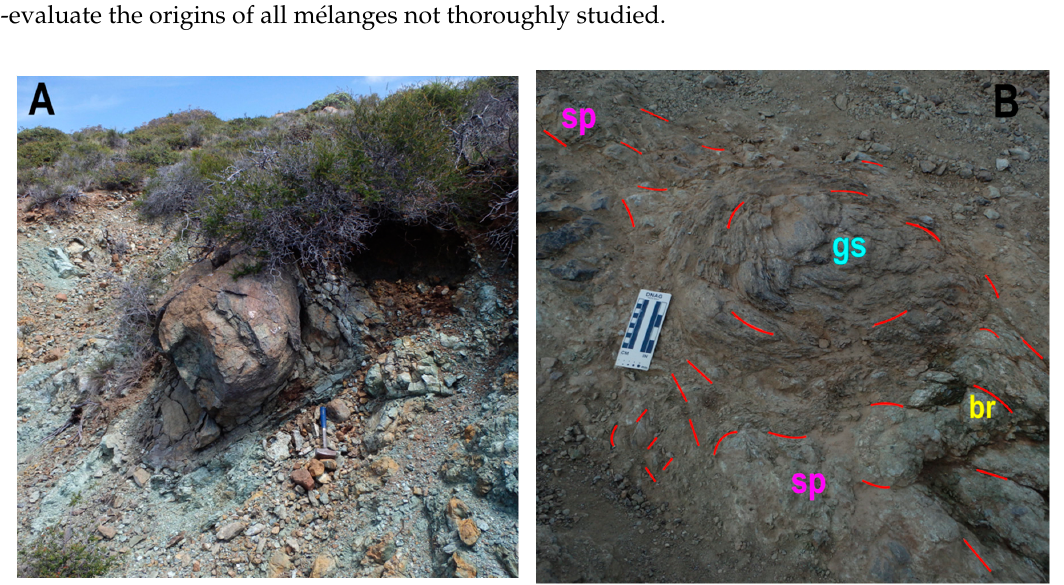
Figure 8. Rounding of serpentinite clasts in mélanges and serpentinite broken formations. ( A ) A combination of jointing, weathering with exfoliation, and shear at the block boundary is producing rounded serpentinite masses in this serpentinite-matrix mélange block that originally had a phacoidal shape. Exposure is near Liberty Gulch in Marin County, California; 40 cm hammer provides scale. ( B ) Coarse-grained (foliated) glaucophane schist (gs) block in Ring Mountain Mélange. Note the concentric foliation of the block. A serpentinite breccia zone (br) occurs at the right side of the block within the serpentinite (sp), which totally surrounds the block in the plane of exposure. Red lines mark foliation planes within the glaucophane schist and shear-fracture planes within the surrounding serpentinite. See text for additional discussion.